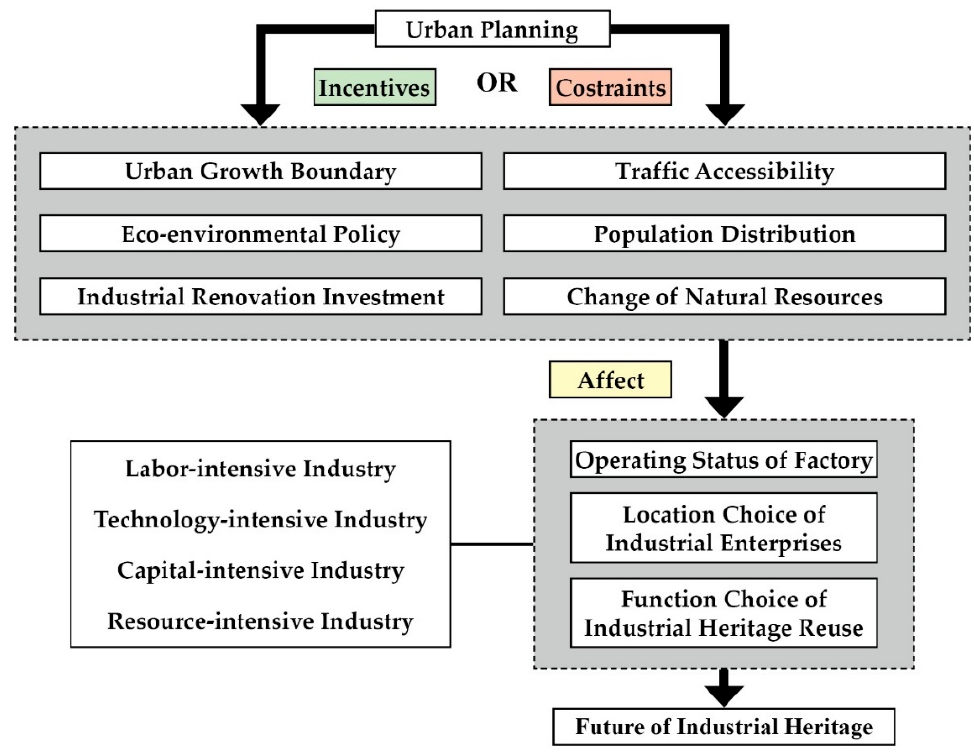
Figure 9. Framework of interpretation of the influencing mechanism (Figure source: own draw- ing).